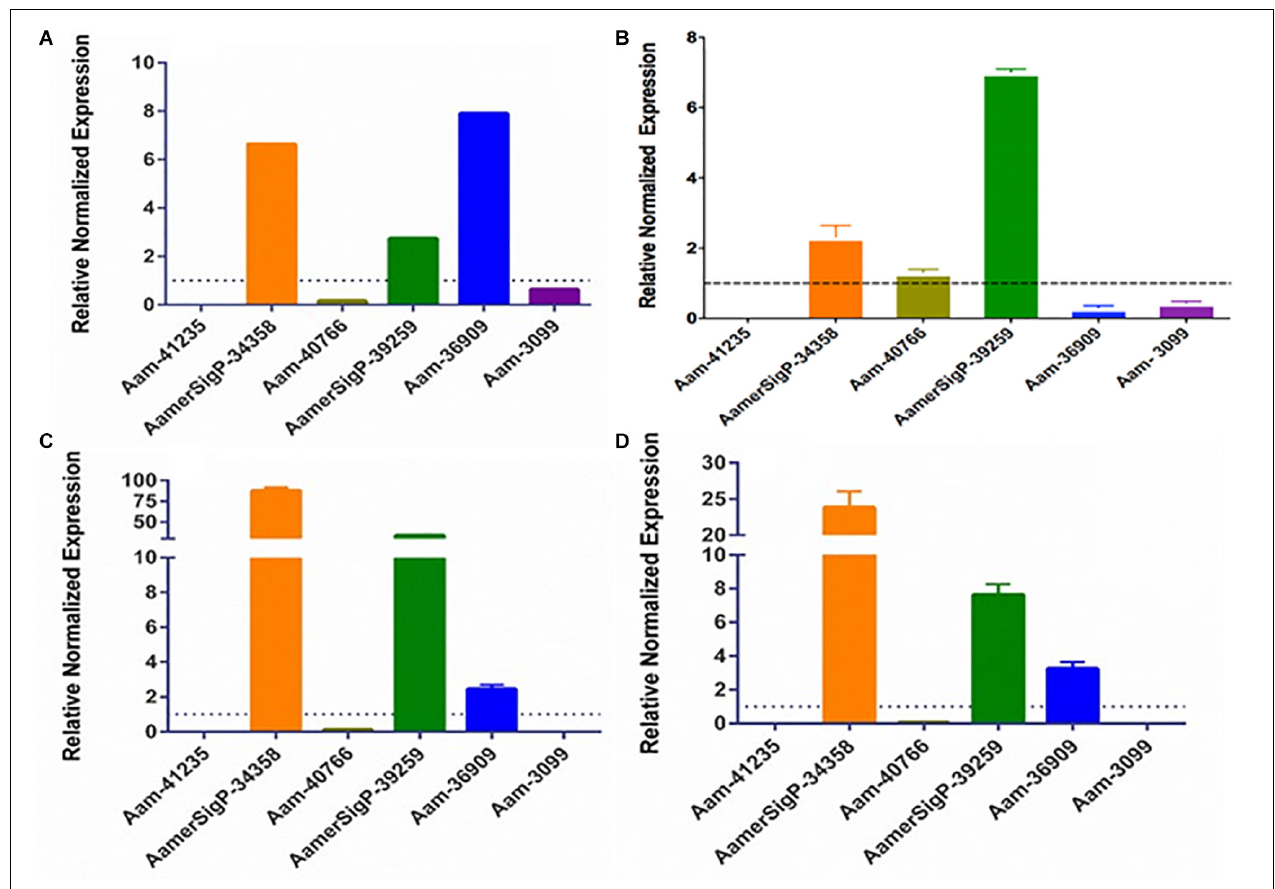
FIGURE 7 | Transcriptional expression of tick GRP genes in unfed tick salivary glands after stress exposure. Quantitative reverse transcriptase PCR (qRt-PCR) was used to determine the transcriptional expression levels of tick GRPs. (A) cold temperature, (B) hot/humid temperature, (C) injury, and (D) oxidative stress. The expression levels in tick control samples were set to 1, as represented by dashed lines. Ubiquitin was used as a housekeeping gene to normalize the transcriptional